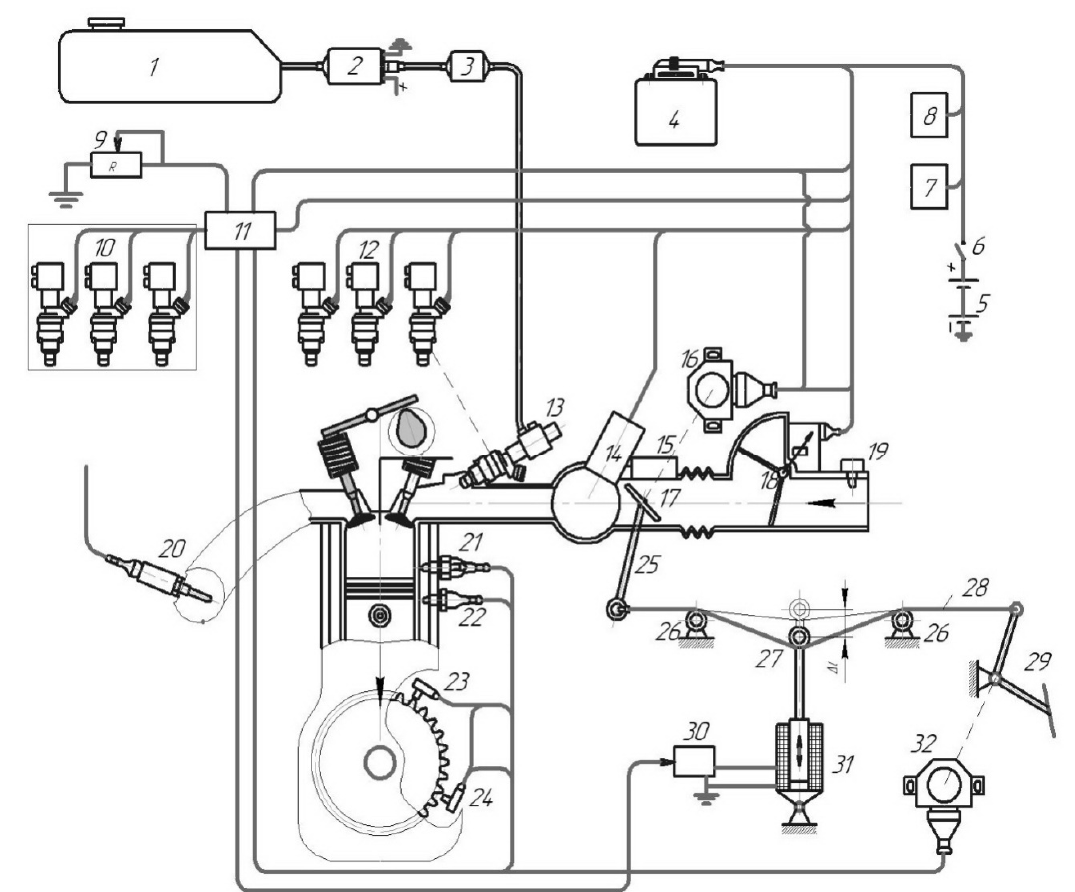
Figure 4. The scheme of experimental power system: 1—fuel tank, 2—electric fuel pump, 3—fuel filter, 4—electronic control device (microprocessor), 5—battery, 6—ignition switch, 7—main relay, 8—pump relay, 9—ballast resistance, 10—disconnected injectors, 11—electronic unit for controlling the nozzles, 12—non-inverting nozzles, 13—fuel distributor, 14—cold start system, 15—idling speed stabilization device, 16—sensor of position and a value of accelerating throttle valve, 17—throttle valve,